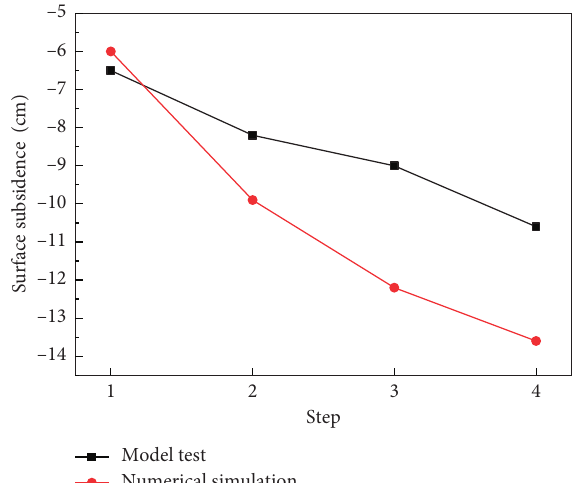
Figure 19: Comparison of maximum surface subsidence in working condition